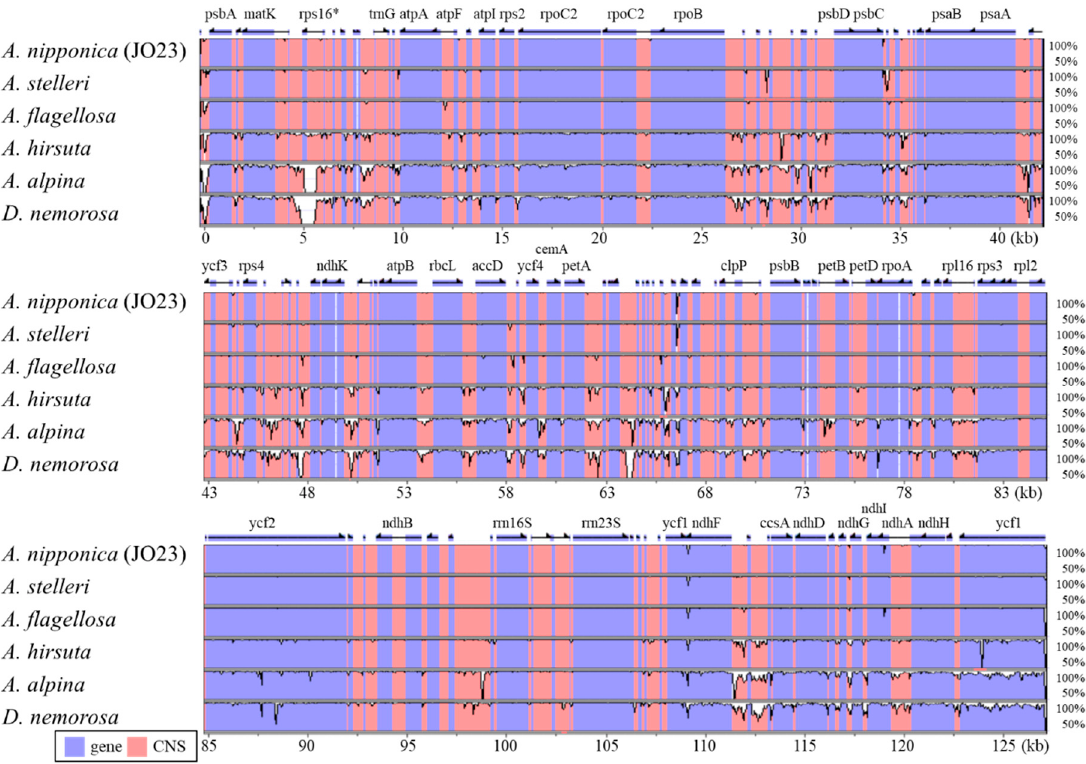
Figure 3. Alignment of the seven chloroplast genomes. VISTA-based identity plots of chloroplast genomes from six Arabis species and Draba nemorosa are compared to A. nipponica strain Midori. Arrows above the alignment indicate genes and their orientation. The names of genes ≥ 500 bp in length are also shown. A 70% identity cut-off was used for making the plots, and the Y-axis represents percent identity (50–100%), while the X-axis represents the location in the chloroplast genome. The blue and pink regions indicate genes and conserved noncoding sequences, respectively.